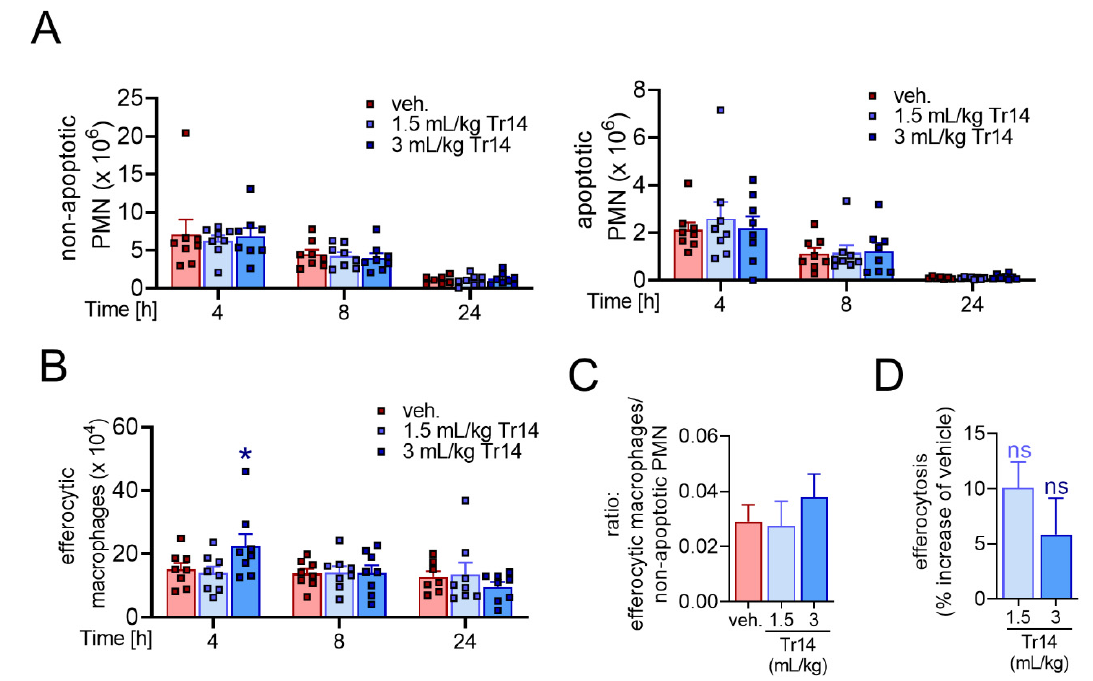
Figure 3. Tr14 enhances macrophage efferocytotic actions in murine peritonitis. ( A – D ) Self-resolving inflammation was initiated by injection of zymosan (0.1 mg/mouse, i.p.) into mice. Prior to zymosan injection, Tr14 (1.5 mL/kg or 3 mL/kg) or vehicle (veh., NaCl 0.9%) were administered i.p. once daily for six days. Peritoneal exudates were collected 4, 8 and 24 h post-zymosan injection ( n = 8), and from naïve untreated mice representing time point 0 h ( n = 6). ( A ) Infiltrated PMNs (Ly6G + , F4/80 − ) were stained with annexin-V and DAPI to determine non-apoptotic PMNs (Ly6G + , F4/80 − , annexin-V − , DAPI − , left) and early and late apoptotic PMNs (Ly6G + , F4/80 − , annexin-V + , DAPI − /+ , right) in the peritoneal lavages, shown as single values and mean + SEM at indicated time points. ( B ) Numbers of efferocytotic macrophages (F4/80 + , Ly6G + ) in the peritoneal lavages, given as single values mean + SEM at indicated time points. * p < 0.05, versus vehicle; two-way ANOVA with Dunnett ´ s multiple comparisons test. ( C ) Ratio of efferocytotic macrophages versus non-apoptotic PMN cell counts 4 h post-zymosan injection. Results are shown as mean + SEM. ( D ) Mean fluorescent intensity (MFI) of Ly6G + PMNs in efferocytotic macrophages (F4/80 + ) after 4 h, measured by flow cytometry, given as % increase versus vehicle. Results are shown as mean +